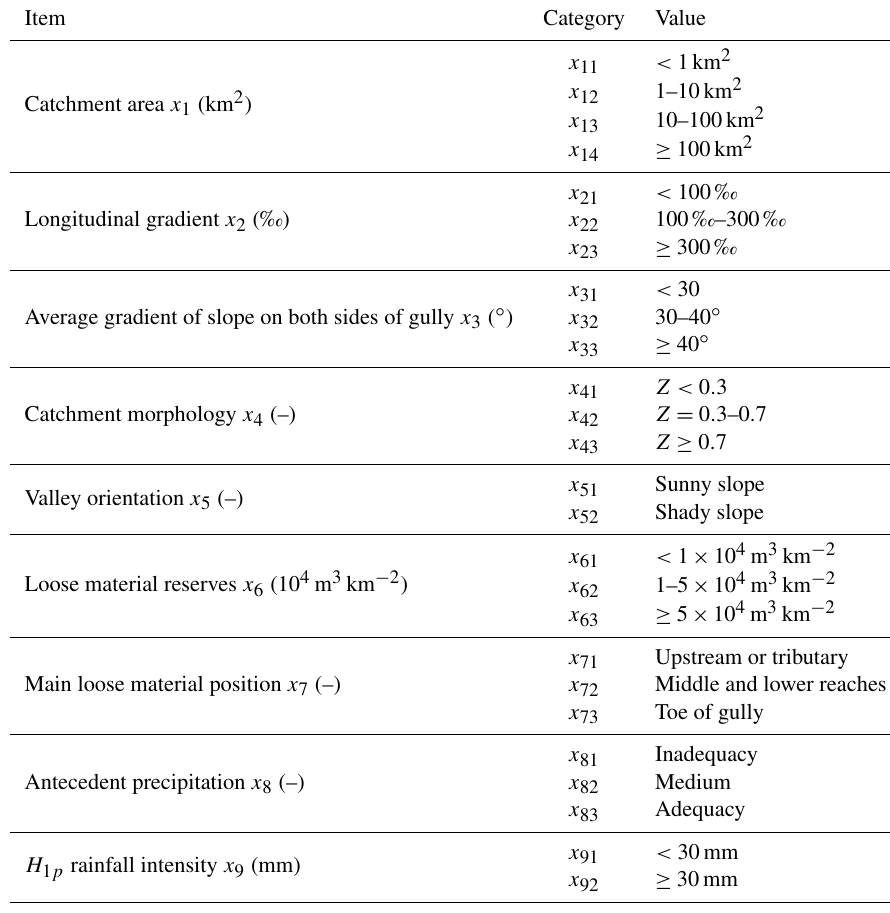
Table 4. Grading criteria of the evaluation indexes in the prediction model of debris flow susceptibility. Item Category Value